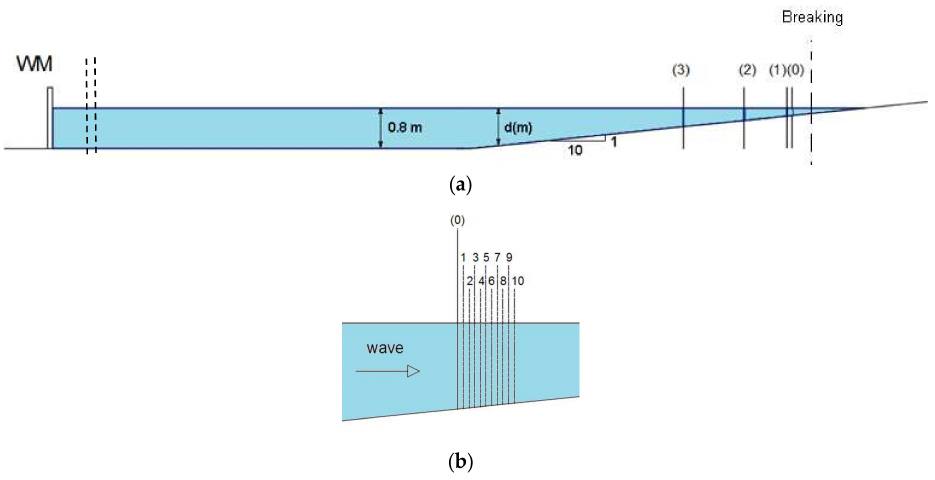
Figure 2. ( a ) Sketch of the wave channel with location of ( a ) the four investigated sections, used to calibrate the numerical model; and ( b ) zoomed view of the region where further ten measurement sections, used for the vorticity analysis, were located. Table 2. Location of the measurements sections used for the code calibration and water depths.